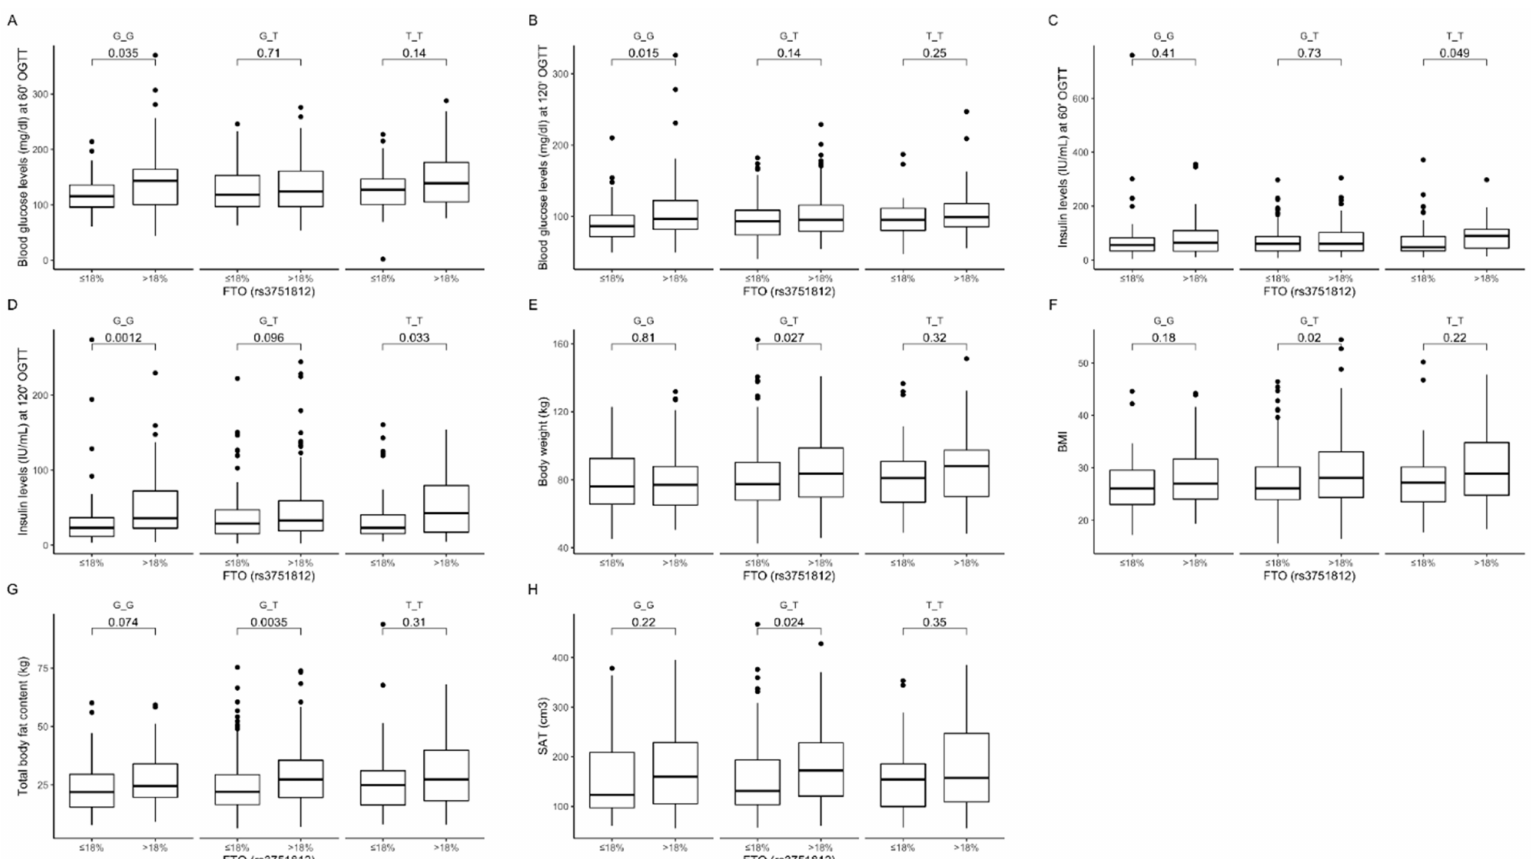
Figure 3. Association of dietary protein intake ≤ 18% and > 18% of total daily energy intake with blood glucose level (mg / dL) at ( A ) 60 min and ( B ) 120 min of OGTT; insulin level (IU / mL) at ( C ) 60 min and ( D ) 120 min of OGTT; ( E ) body weight (kg); ( F ) BMI (kg / m 2 ); ( G ) total body fat content (kg); and ( H ) SAT (cm 3 ) in FTO rs3751812 genotype